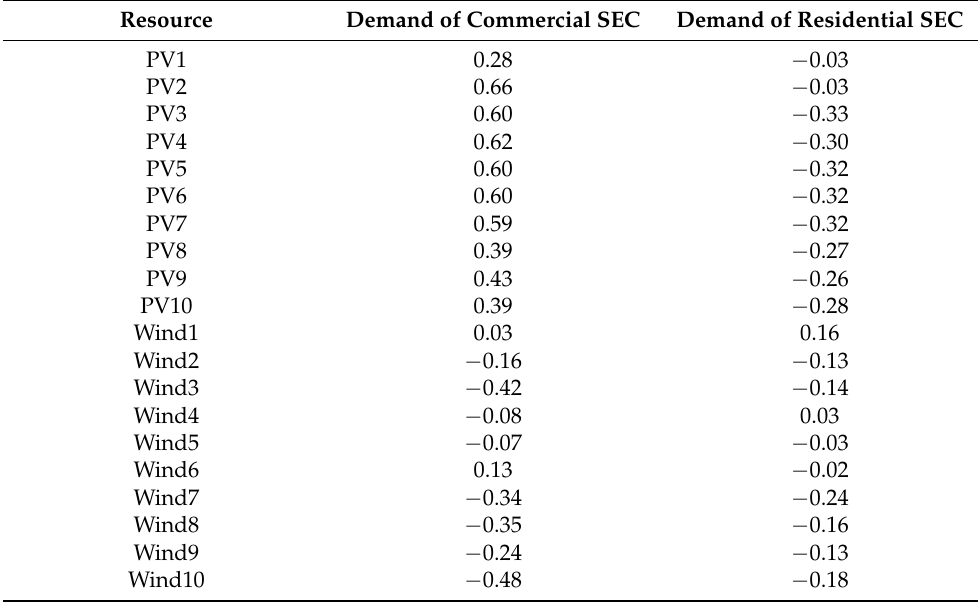
Table 3. Pearson’s linear correlation coefficient between demand and